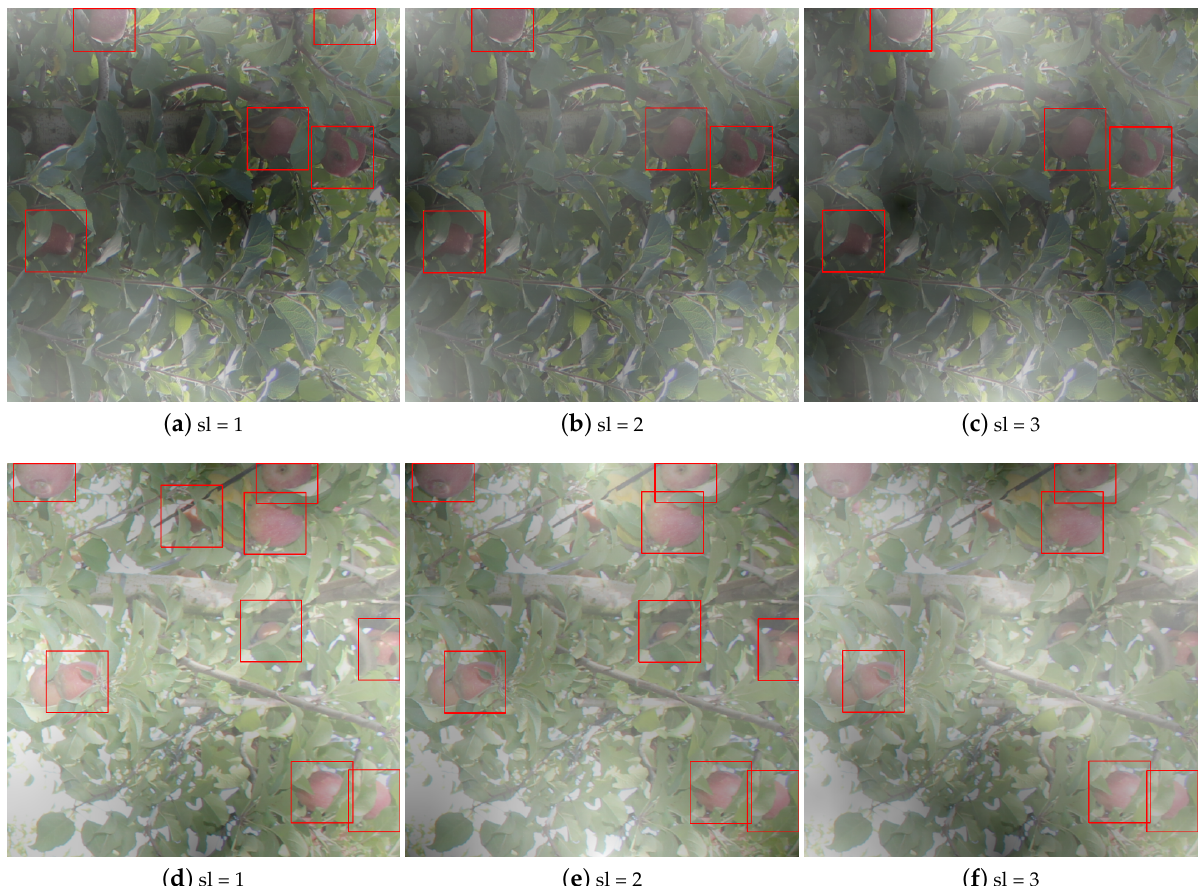
Figure 10. Example of two different patches (upper and above rows) with fog (sl stands for severity